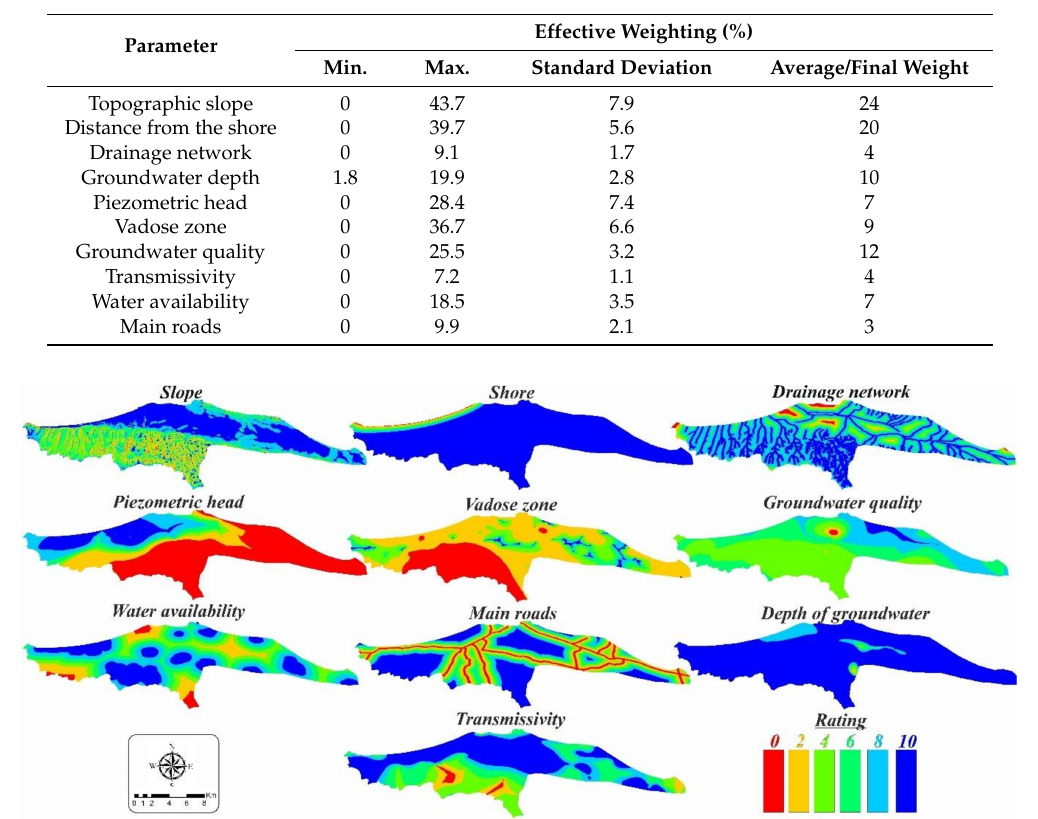
Figure 3. Thematic maps of the site suitability index to apply MAR in the coastal aquifer of Anthemountas